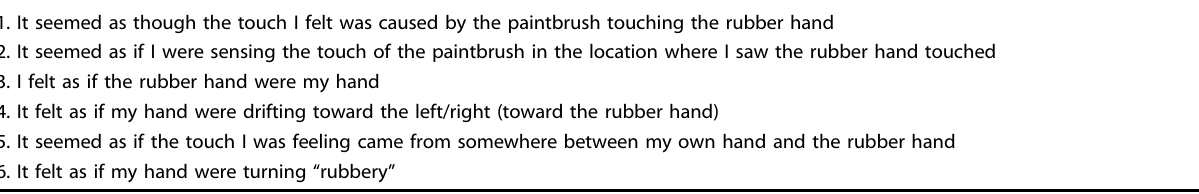
Table 1. Embodiment questionnaire (Botvinick and Cohen 6